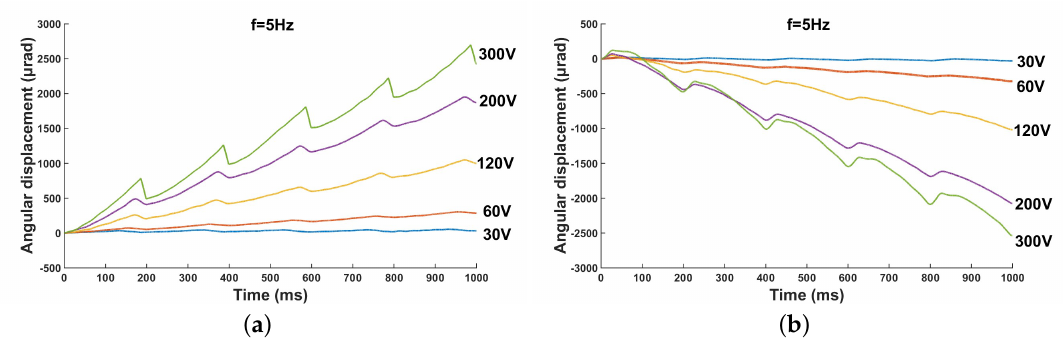
Figure 13. Angular displacement under various driving voltages: ( a ) clockwise rotation; and ( b ) counterclockwise